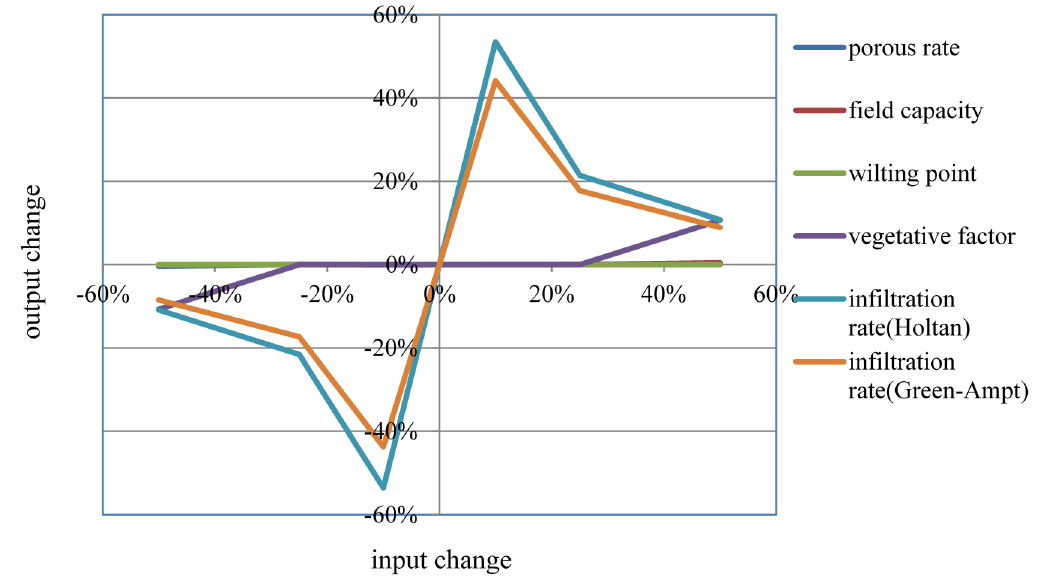
Figure 6. Sensitivity analysis results for model parameters used in BMP/LID module: porous rate, field capacity, wilting point, vegetative factor, infiltration rate (Holtan), and infiltration rate